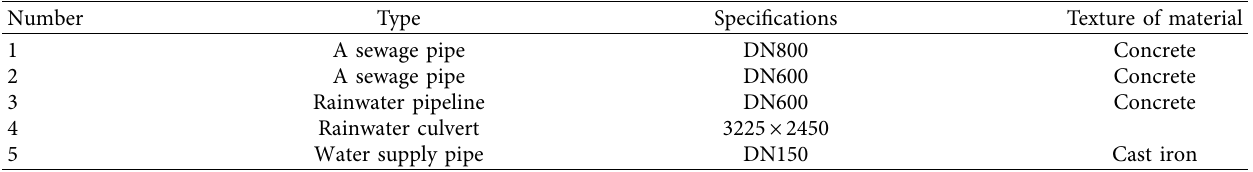
Table 14: List of surrounding underground pipelines.